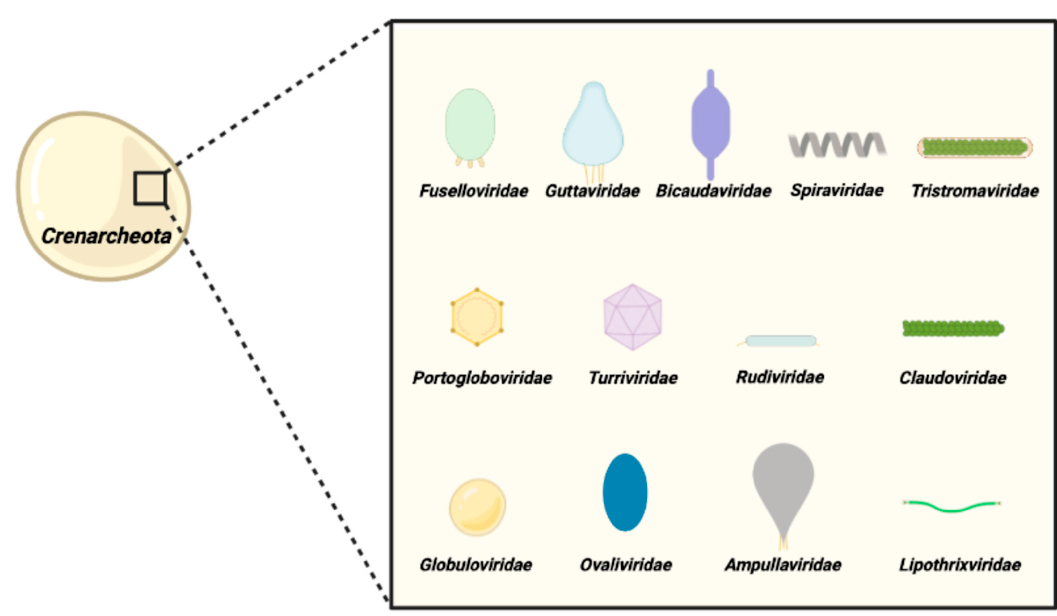
Figure 1. Representation of viruses infecting Creanarcheota. The schematic morphologies of virions are shown above the corresponding family names.